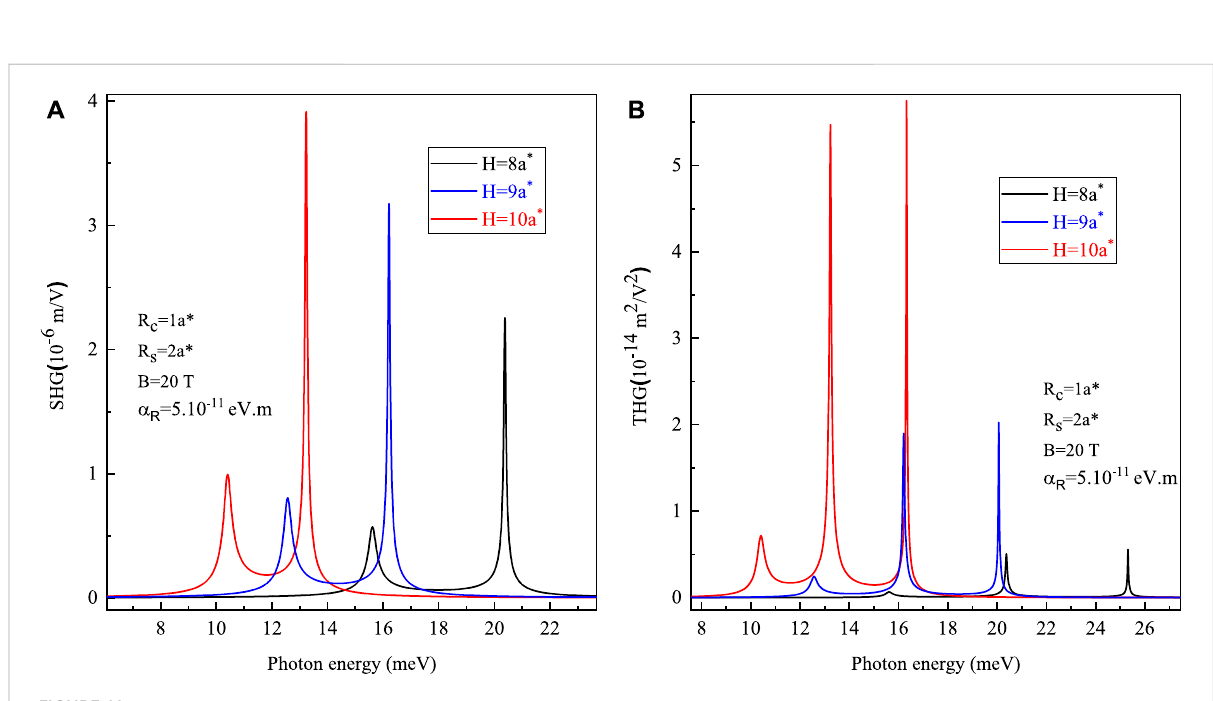
FIGURE 11 TheSecondahrmonicgeneration (A) andthirdharmonicgeneration (B) asfunctionofincidentphotonenergywithdifferentheights H